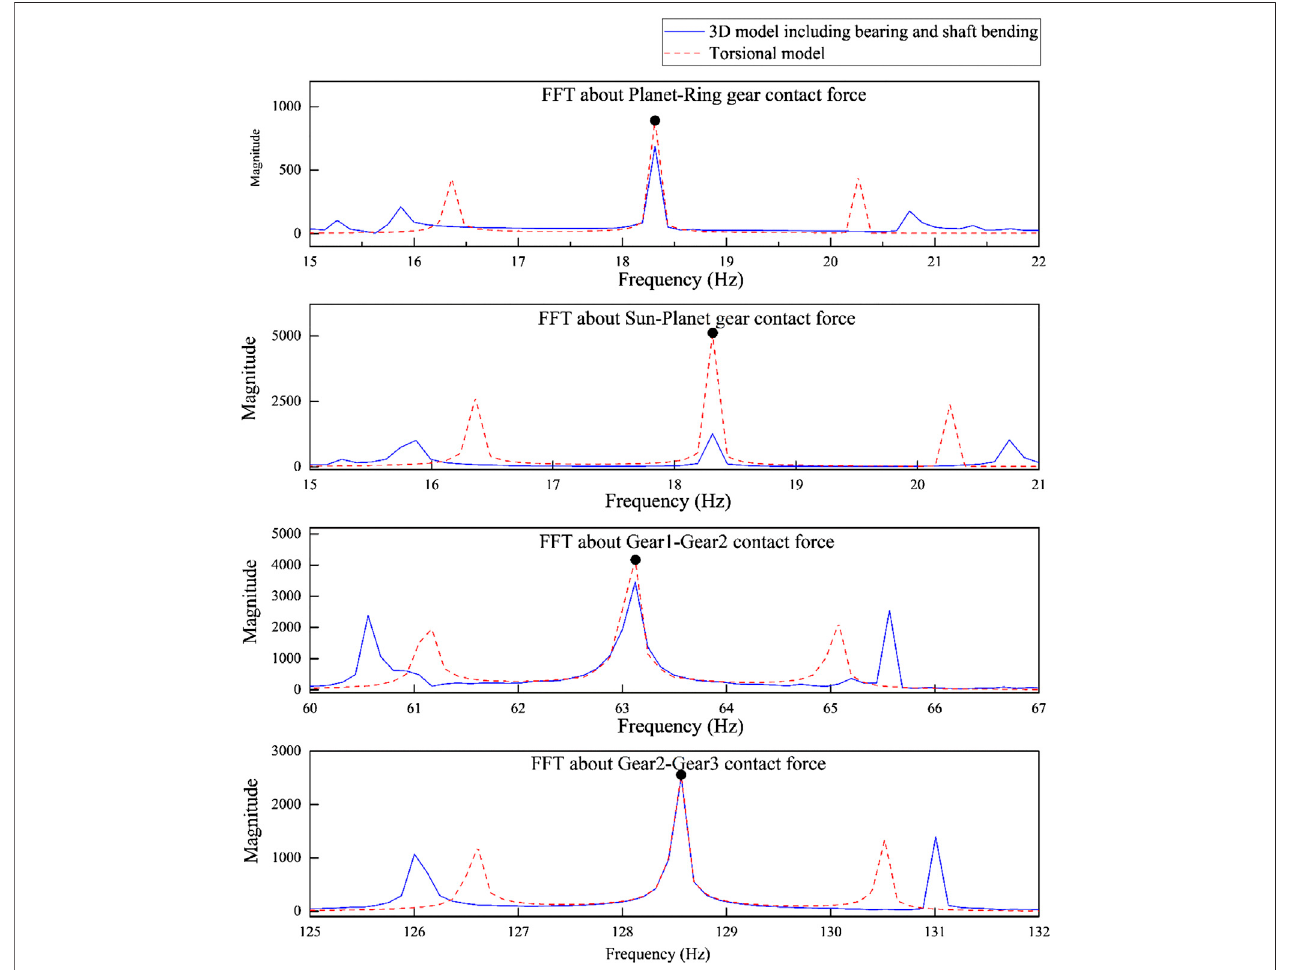
FIGURE 9 | Comparison of the gear mesh frequency and the sideband